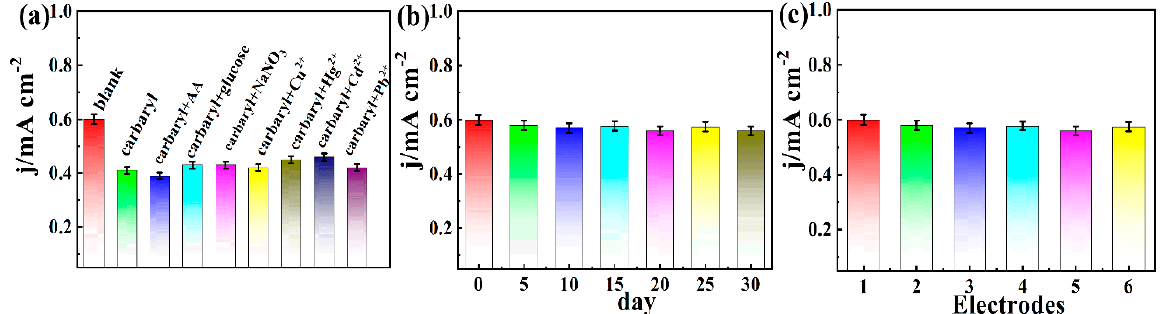
Figure 7. ( a ) Selectivity test of electrochemical carbaryl biosensor. ( b ) Current response histogram of electrochemical carbaryl biosensor measured for 30 consecutive days of carbaryl. ( c ) Current response histogram of six AChE/COF DHNDA-BTH /GCE to detect carbaryl.